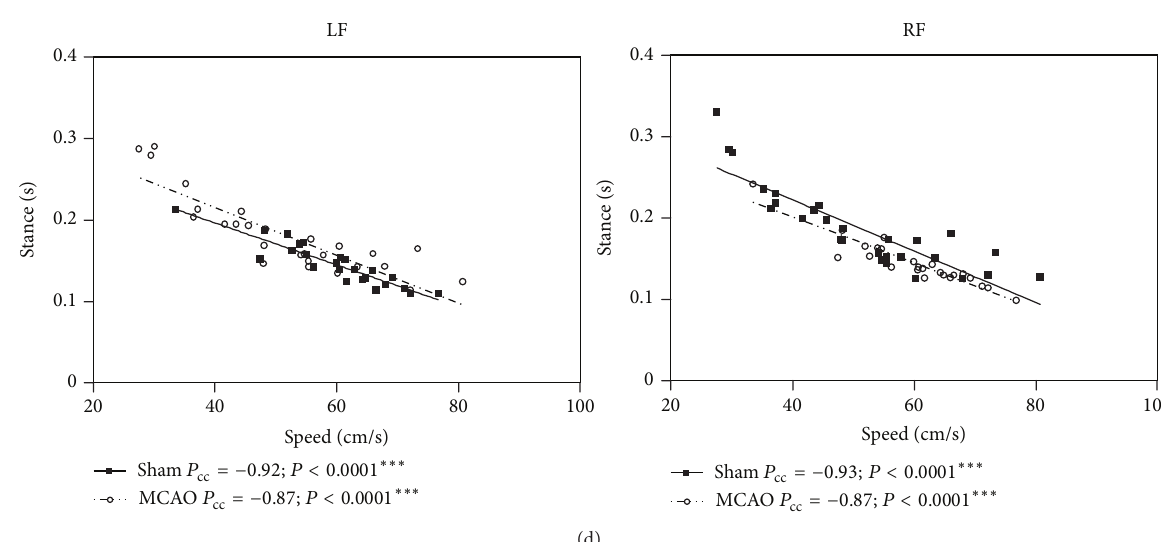
Figure 5: Gait parameter correlations. Scatter plots showing the correlations between gait parameters and body weight ((a), (b)) and locomotor speed ((c), (d)) of the left and right forepaws. Linear regression lines were plotted in each group (solid lines for sham-operated and dotted lines for MCAO rats). The values of Pearson’s Products Moment Correlations Coefficients ( 𝑃 group. Maximum contact area (a) and toe spread (b) showed positive correlation with body weight. By contrast, the maximum contact area (c) and stance (d) showed negative correlations with locomotor speed. Values for the left and right hindpaws followed the same correlation patterns (data not